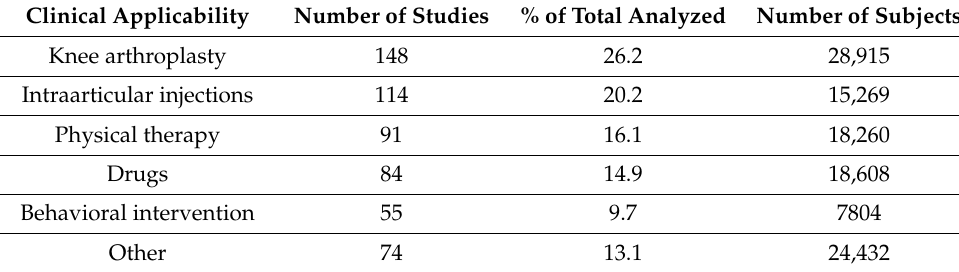
Table 1. Clinical trials categorized based on clinical